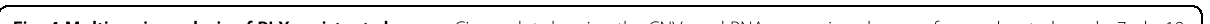
Fig. 4 Multi-omic analysis of PLX-resistant clones. a Circos plot showing the CNVs and RNA expression change of genes located on chr 7, chr 18, and chr 21. The outer circle shows the CNVs, which are represented with normalized copy number pro fi ling of PLX-resistant clones versus control from Control-FREEC analysis. Gene expression (Gene Expr) change was represented by log 2 fold change (log 2 FC) between PLX-resistant clones and controls from DESeq2 analysis. For better color representation, a few extreme CNV values > 5 were truncated to 5; and a few extreme positive and negative log 2 FC with absolute value > 2 were shrunk to 2 and – 2, respectively. b A summary of mutation types (mut.type) of coding SNVs and small indels in each sample compared with parallel control (DMSO-A375). c Heatmap comparing the alternative allele frequency (Alt Allele Freq) of all coding SNVs or small indels identi fi ed in all the PLX-resistant clones. d Heatmap comparing the gene promoter methylation status and gene expression change. Promoter methylation statuses were represented with normalized enrichment scores (NES) between controls (parental control and parallel control) and the PLX-resistant clones from mCSEA analysis. Gene expression changes were represented with log 2 FC between controls and the PLX-resistant clones from DESeq2 analysis. Genes with FDR < 0.2 from mCSEA analysis and q value < 0.05 from DESeq2 analysis are shown. For better color representation, three extreme log 2 FC values that were < – 3 were adjusted to – 3. e Hypomethylation of the EPHA3 promoter in the bc5-2 subpopulation. Each point represents the methylation of each sample. Lines link the mean methylation of each group. The Kolmogorov – Smirnov (KS) test leading edge panel marks with green bars indicating those CpGs contributing to the enrichment score (ES) and with red bars indicating those not contributing. This plot was obtained using the mCSEA